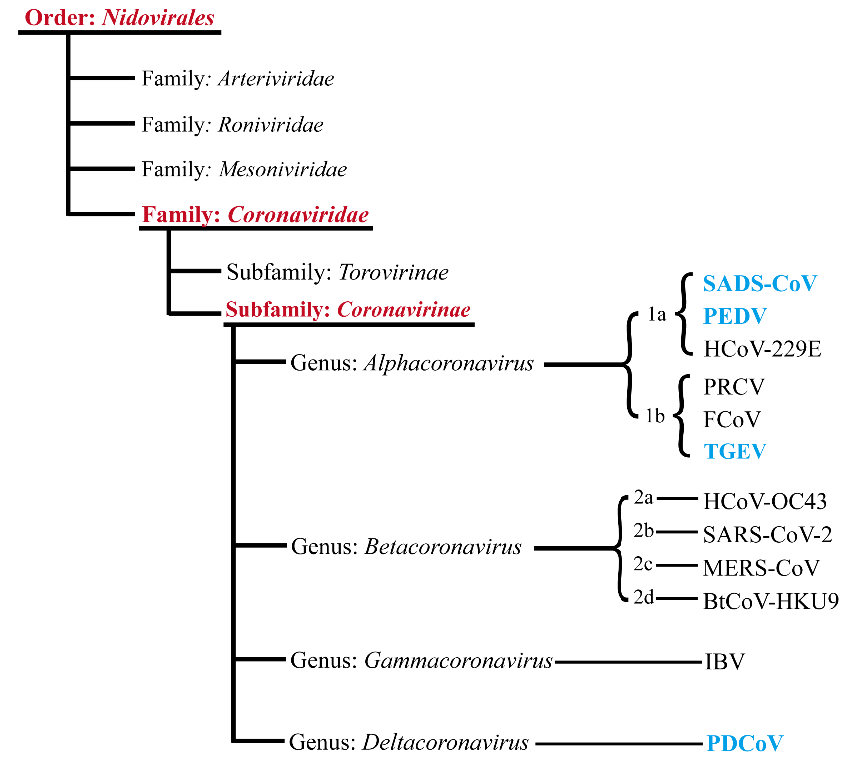
Figure 1. Taxonomy of SeCoVs. Schematic diagram showing the classification of coronaviruses. The four known SeCoVs are marked in blue in the figure. Abbreviations: BtCoV, bat coronavirus; IBV, infectious bronchitis virus; and PRCV, porcine respiratory coronavirus.